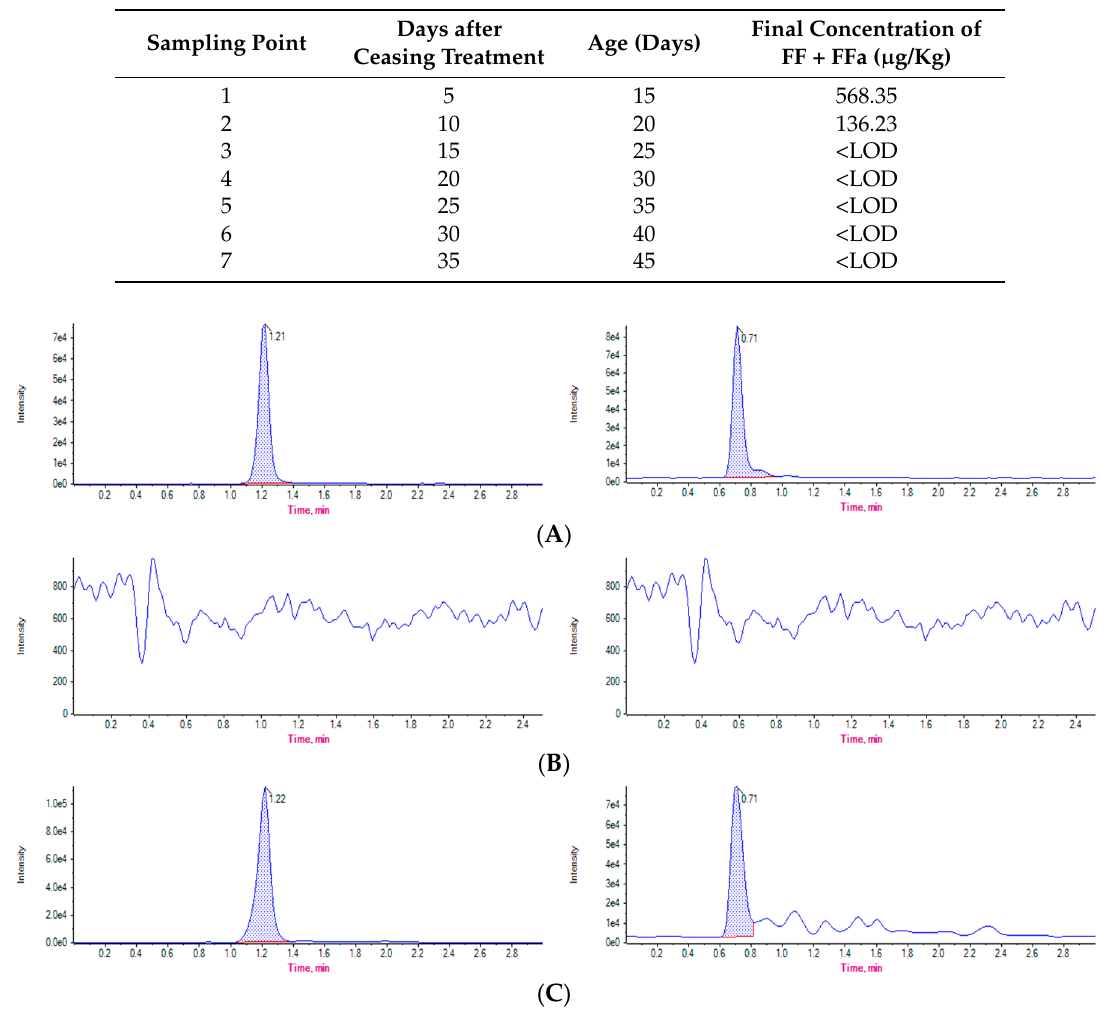
Figure 2. Representative chromatograms from ( A ) Certified standard injection of FF (left) and FFa (right), ( B ) Blank samples, free of residues of FF (left) and FFa (right), ( C ) Droppings samples with residues of FF (left) and FFa (right), from experimental animals at day 10 after ceasing treatment (sampling point 2).